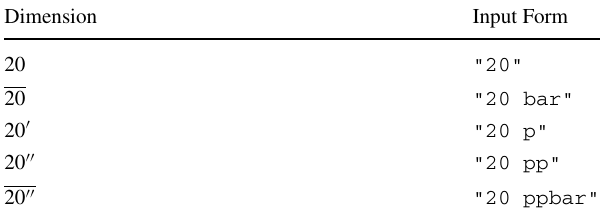
Table 18 Input form of the dimension